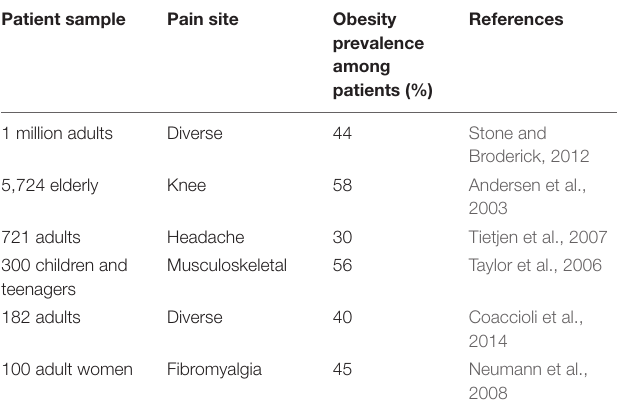
TABLE 1 | Pain sensitivity correlate with obesity